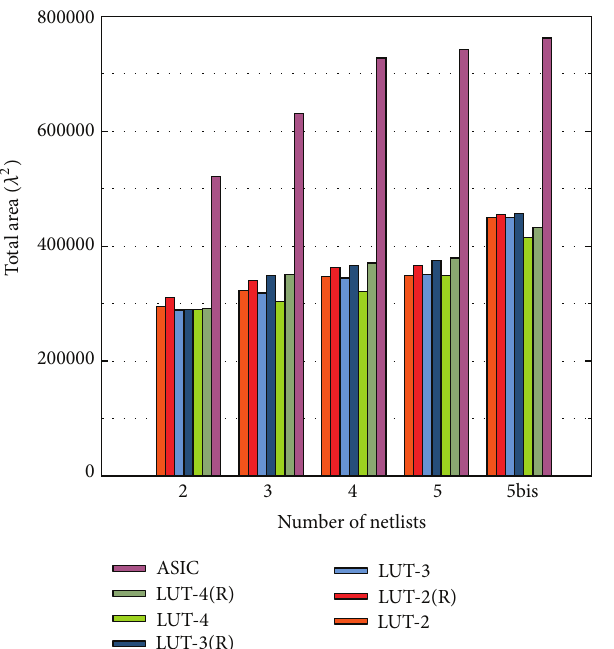
Figure 26: Total area comparison for OpenCores benchmarks [20] SET2 after place and